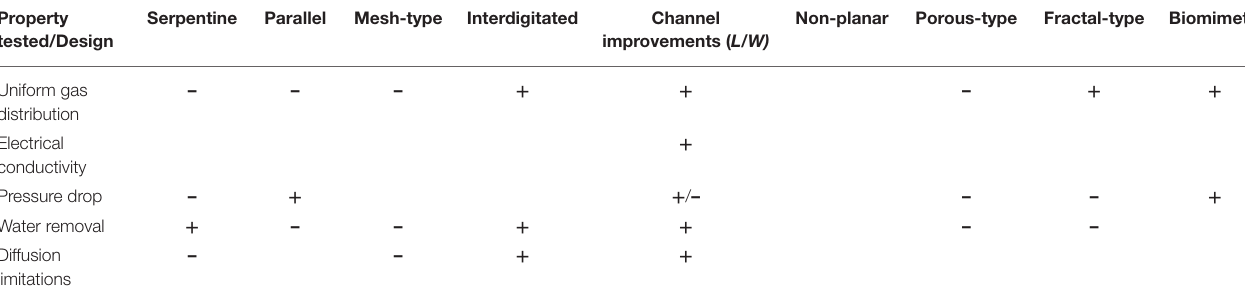
Non-planar Porous-type improvements ( L/W)